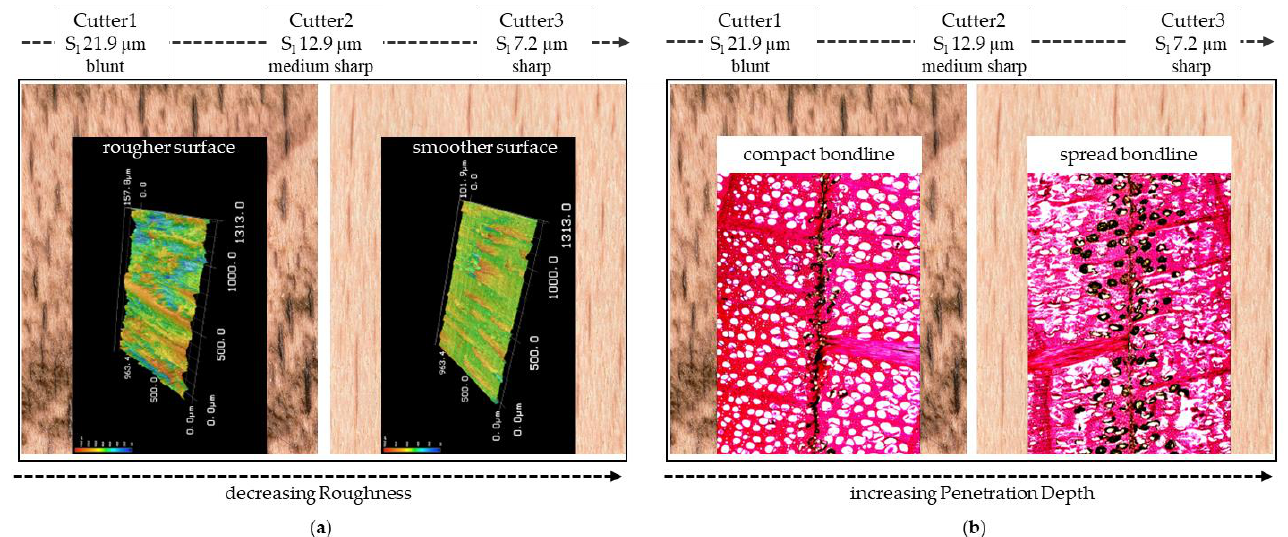
Figure 7. Resulting wood surfaces for beech after processing with low feed rate (F R 1, 4 m min − 1 ) and different sharp cutters (S l ; microscopically measured cutting-edge radius); trend observed change in roughness, the blunt cutter (Cu1) resulted in a rougher surface and the sharp cutter (Cu3) resulted in a smoother surface ( a ), and the trend observed change in penetration depth, the blunt cutter (Cu1) resulted in a compact bondline and the sharp cutter (Cu3) resulted in a spread bondline ( b ); the surfaces machined with a low feed rate and a blunt cutter showed a charring of the wood surface.